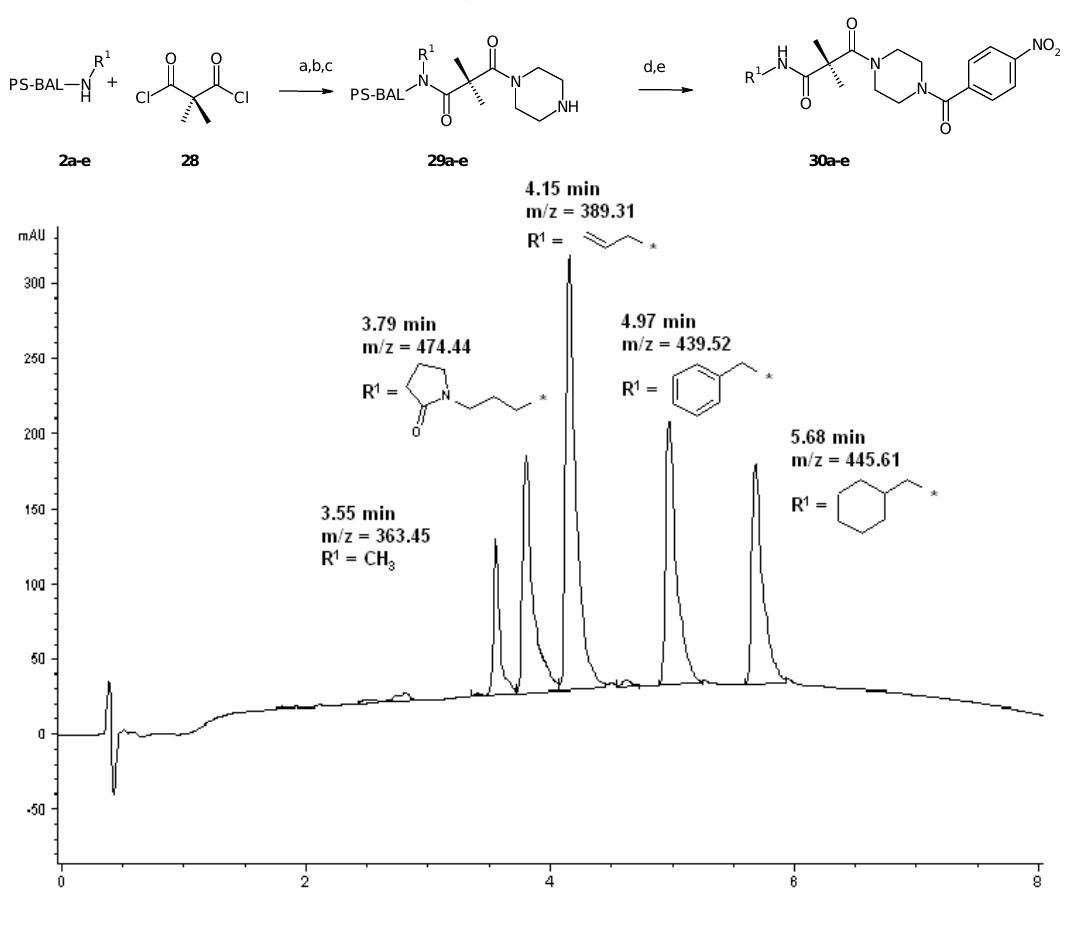
Figure 1. LC-MS (EI-positive mode) of mixture of 30a -